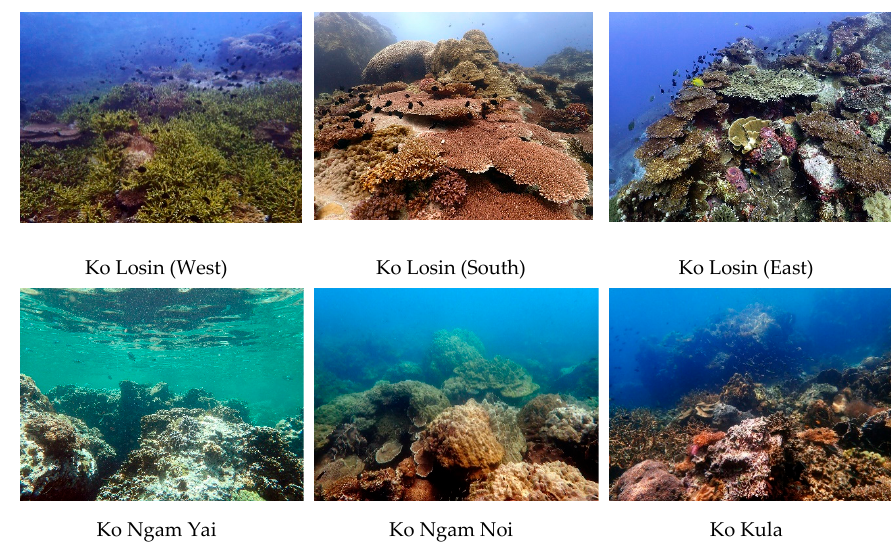
Figure 8. Underwater photographs showing the dominant coral species at the study sites.